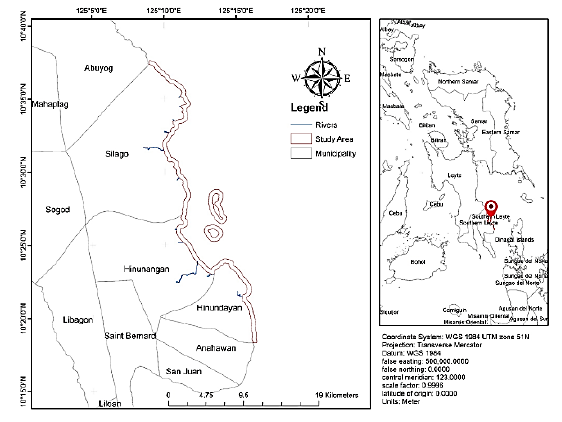
Figure 1. Location of the study area along the east coast of Southern Leyte,